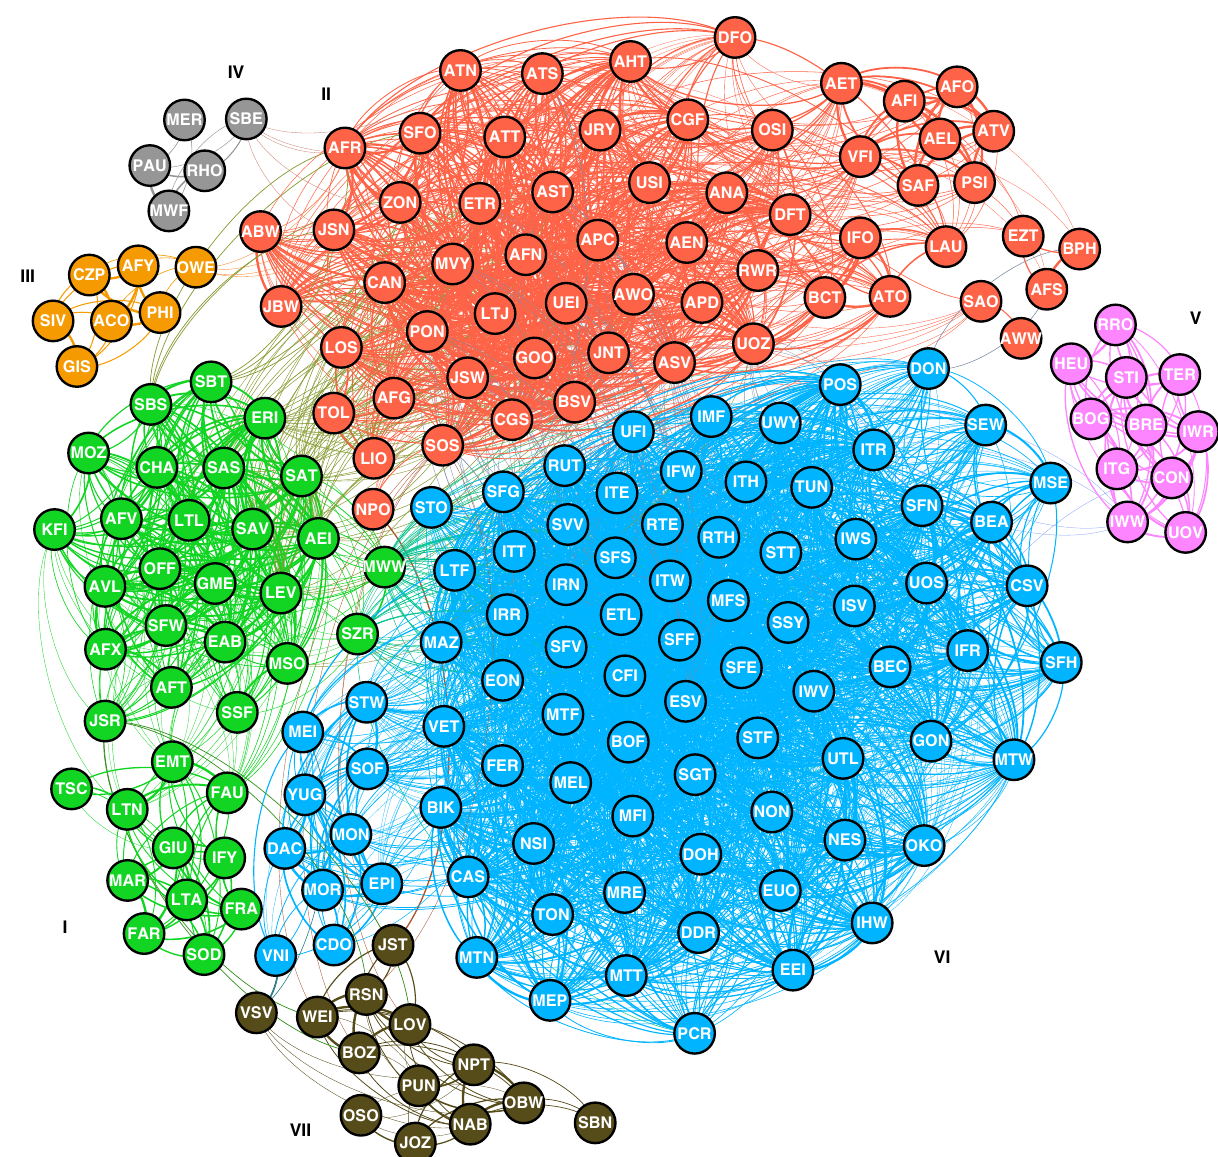
Fig. 5 Similarity network for the zeolite structures. The layout of the network is decided by a force-directed algorithm. Communities are identi fi ed using a clustering algorithm based on the modularity optimization. To verify the weighting effects, another structural similarity network was constructed using identical weights for all building units (Supplementary Fig.